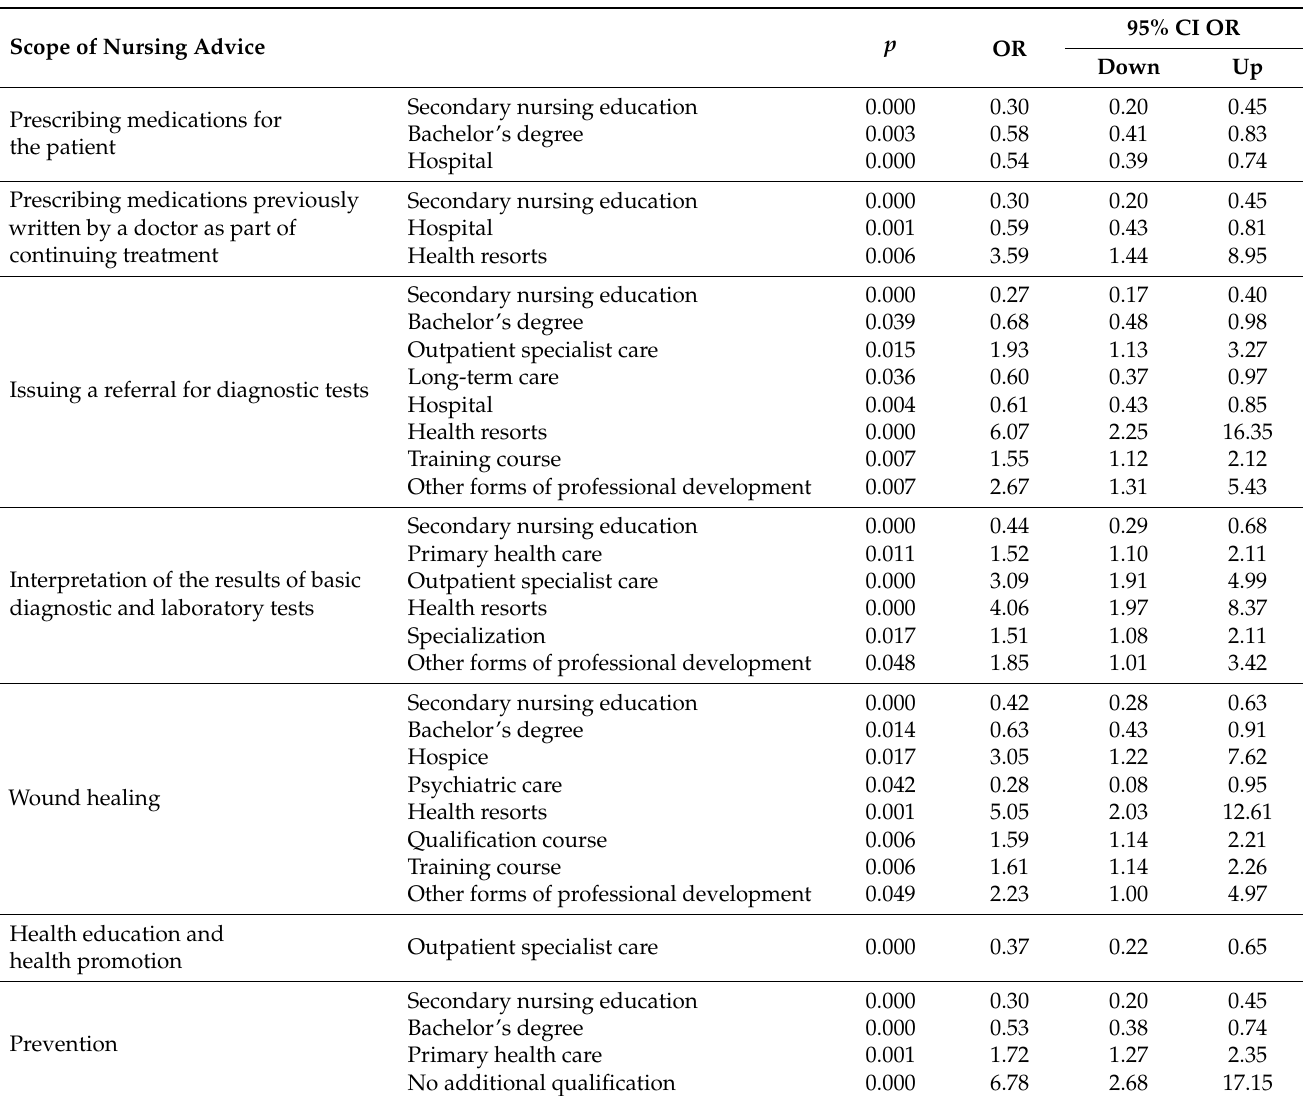
Table 3. Statistically significant variables influencing nurses’ opinions regarding the scope of nursing advice. Logistic regression—stepwise,